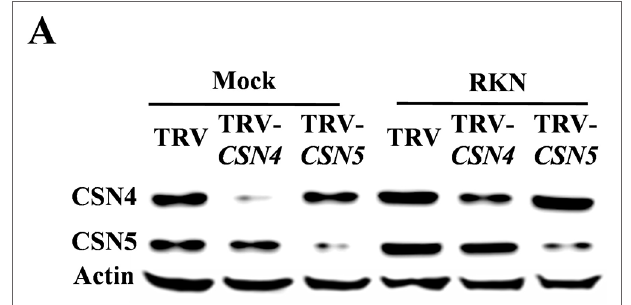
FIGURE 4 | The changes in abundance of CSN4 and CSN5 proteins in CSN4 - or CSN5 -silenced tomato lines at 24 h after infection with Meloidogyne incognita . (A) Immunoblot analysis of CSN4 and CSN5 protein levels in roots of tobacco rattle virus (TRV)- CSN4 and TRV- CSN5 and control plants using anti-CSN4 and